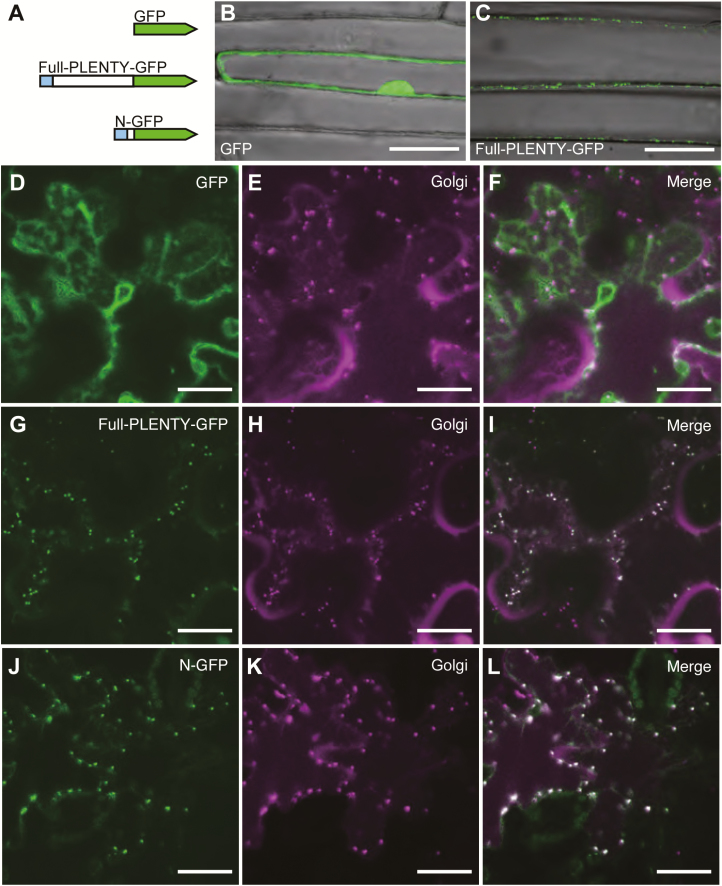
Subcellular localization of PLENTY–GFP fusion proteins. (A) Overview of the three GFP fusion protein constructs; GFP, Full-PLENTY–GFP, and N–GFP containing the first 58 amino acids of the N-terminal region of PLENTY. PLENTY has a putative secretory signal peptide at the N-terminus (shown in blue). (B–L) Confocal microscopic images of the localization of a series of PLENTY–GFP fusion proteins driven by the CaMV 35S promoter. (B, C) The transient expression in onion epidermal cells transformed using particle bombardment. (D–L) Transient expression in N. benthamiana pavement cells co-expressing the mCherry-fused cis-Golgi marker, transformed using A. tumefaciens infiltration. The constructs used for each analysis are shown in each panel. Merged images show the cytoplasmic localization of GFP (F) and the Golgi localization of Full-PLENTY–GFP and N–GFP (I, L). Scale bars=50 μm in (B, C) and 25 μm in (D–L). Similar GFP localization was observed in >10 transformed cells.